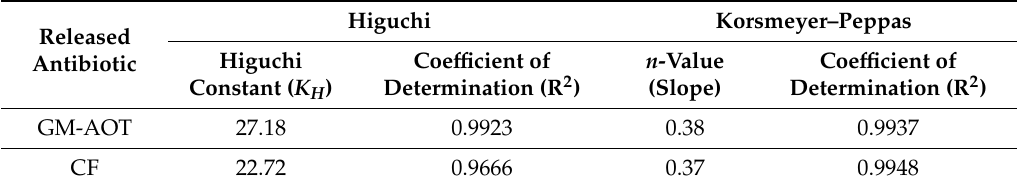
Figure 5. ( A ) Release profile of GM-AOT from PCL/cPVA-ASP microspheres. ( B ) GM-AOT release data represented in a Higuchi plot. ( C ) GM-AOT release data represented in a Korsmeyer–Peppas plot. ( D ) Release profile of CF from PCL/cPVA-ASP microspheres. ( E ) CF release data represented in a Higuchi plot. ( F ) CF release data represented in a Korsmeyer–Peppas plot. All data represents an average ± standard deviation of triplicate measurements. Table 2. Parameters of the linear fits from Higuchi and Korsmeyer–Peppas plots.